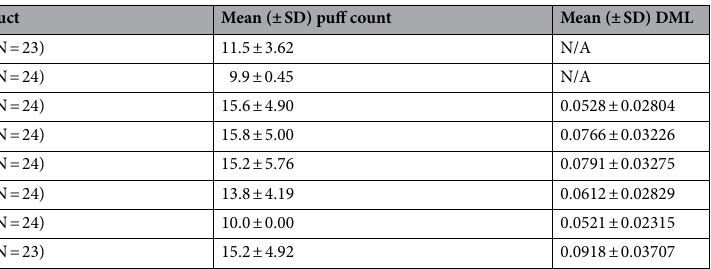
Table 5. Summary product usage. N Number of Subjects; DML Device Mass Loss; SD Standard Deviation; Product A—combustible cigarette (ad libitum); Product B—combustible cigarette (fixed); Product C— ePen2.0BT18 (ad libitum); Product D—ePen3.0BT18 (ad libitum); Product E—ePen3.0MB18VP (ad libitum); Product F—ePen3.0MB30VP (ad libitum); Project G—ePen3.0MB18VP (fixed); Product